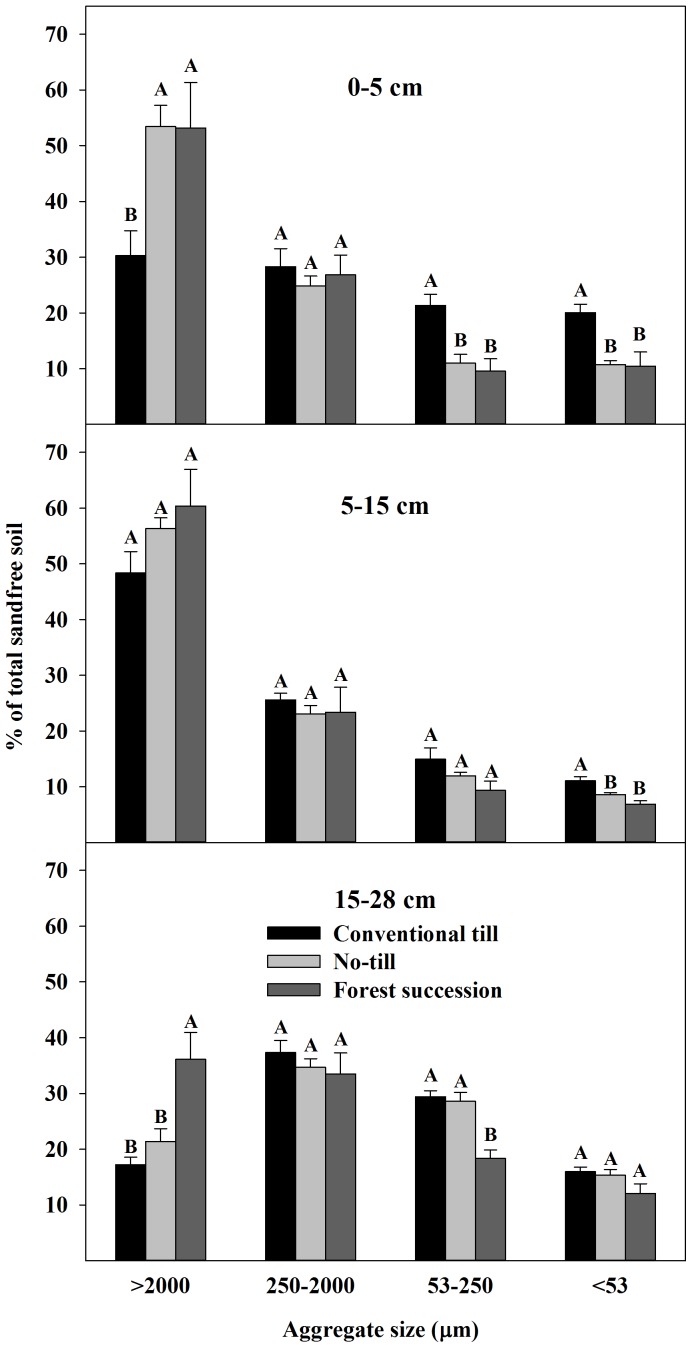
Distribution of water-stable aggregates on a sand-free soil basis (mean ±1 SE) at the Horseshoe Bend Agroecosystem Experiment (n = 4), Athens, GA, USA, October 2007.Different letters within an aggregate size class and depth class represent a significant difference between land uses (α = 0.05). See also Table S2.